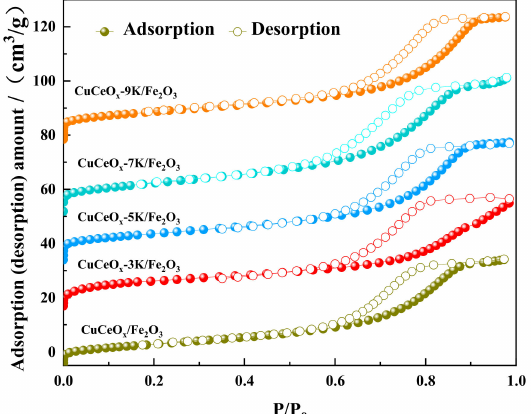
Figure 3. The N 2 adsorption/desorption isotherms of CuCeO x -xK/Fe 2 O 3 catalysts. Table 3. The pore structure properties of the CuCe-xK/Fe 2 O 3 catalyst.